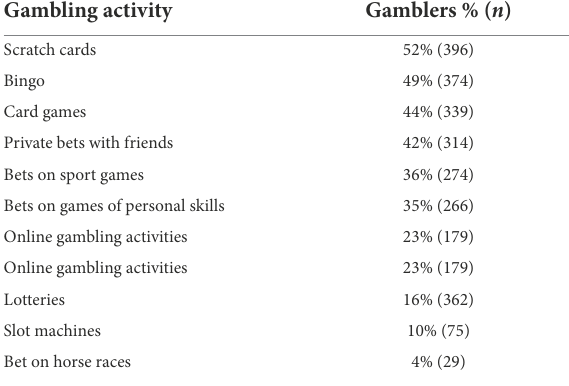
TABLE 2 Prevalence of gamblers on each gambling activity in Study 1 ( n = 761).